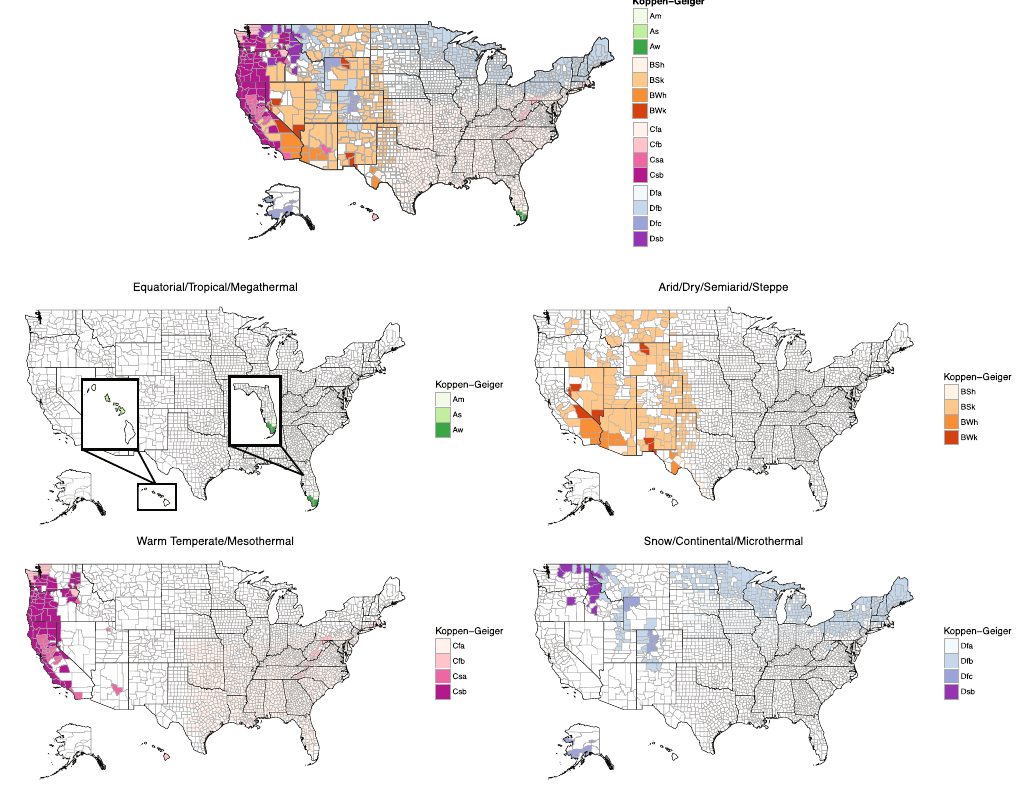
Figure 1. Hospital Compare Data By County with Major Climate Designations: A Map of the United States Showing Hospital Compare Data Mapped to Köppen-Geiger Climate Classifications. Map of the United States was generated in R 30 , using the following libraries: choroplethr (version: ‘3.5.2’,